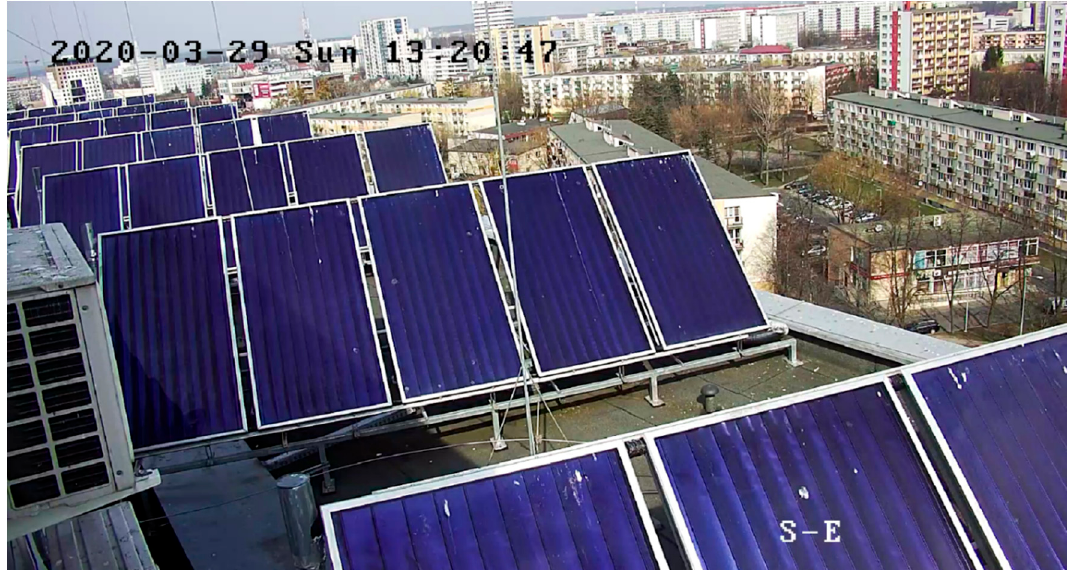
Figure 1. Flat plate solar collectors connected in series of five panels grouped into seven subarrays.